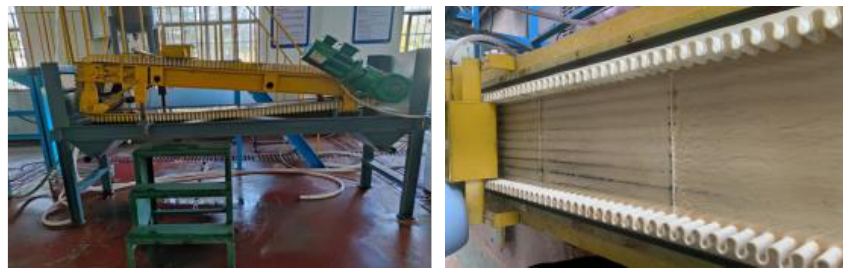
Figure 4. Equipment of plate high gradient magnetic separator.